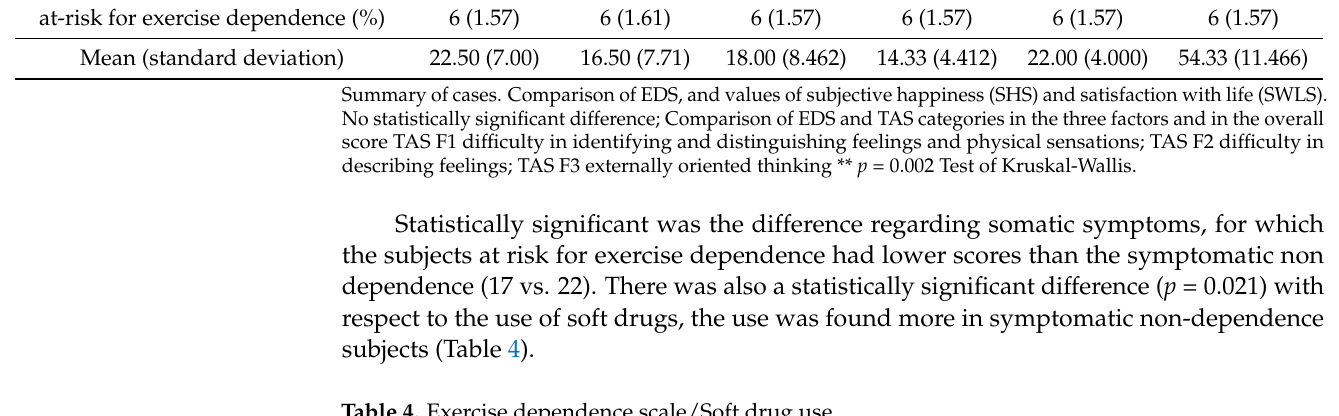
Table 4. Exercise dependence scale/Soft drug